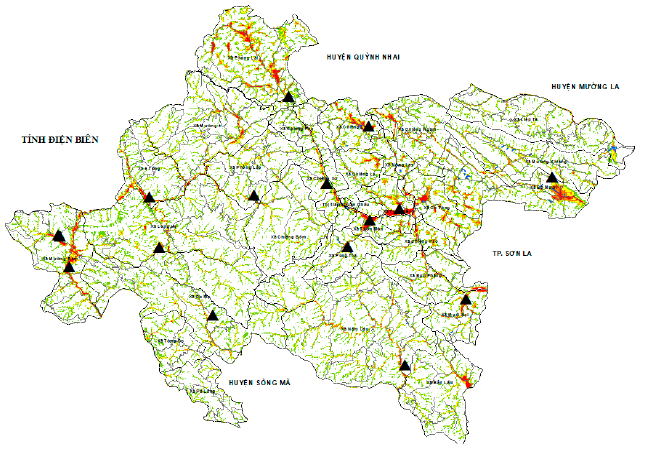
Figure 5. Comparison of forecast results with historical